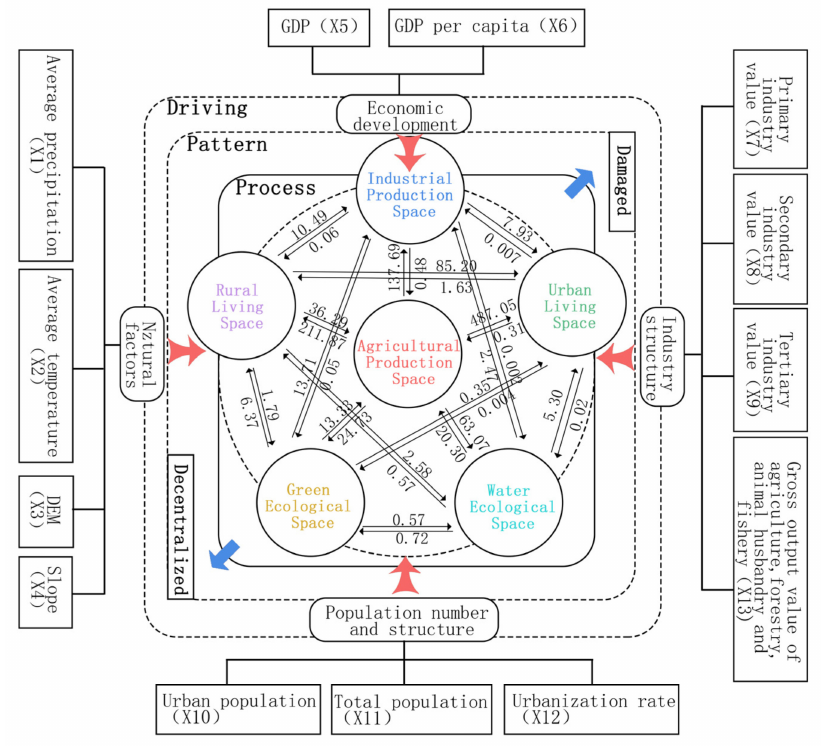
Figure 11. The driving mechanism of PLES evolution in Chaohu Lake